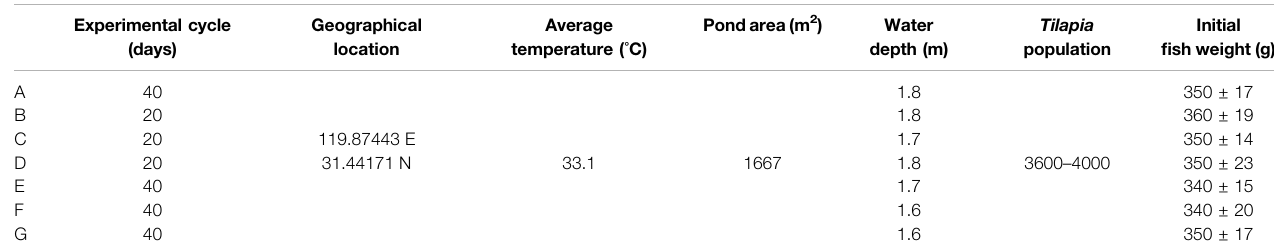
TABLE 1 | Basic information of Tilapia